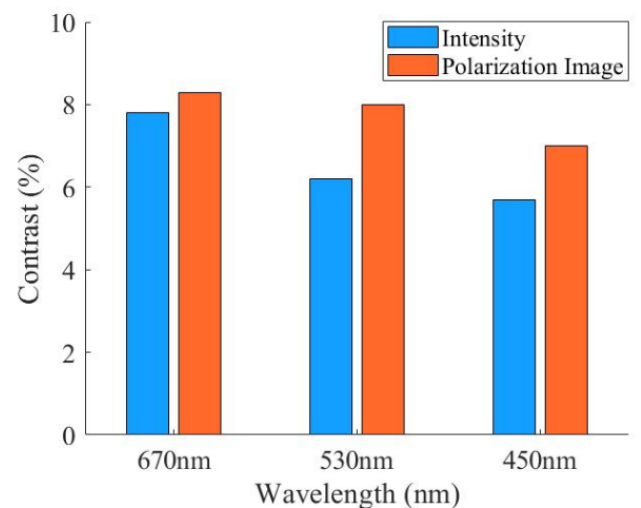
Figure 9. Polarization contrast of multi-band targets.